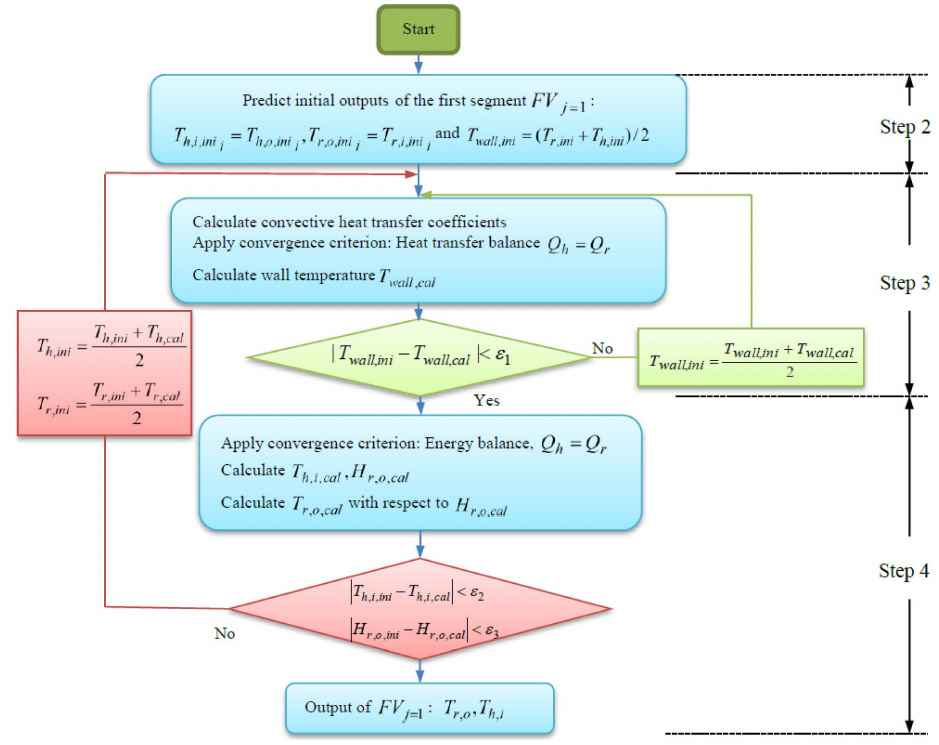
Figure 7. Finite volume calculations for the first segment FV